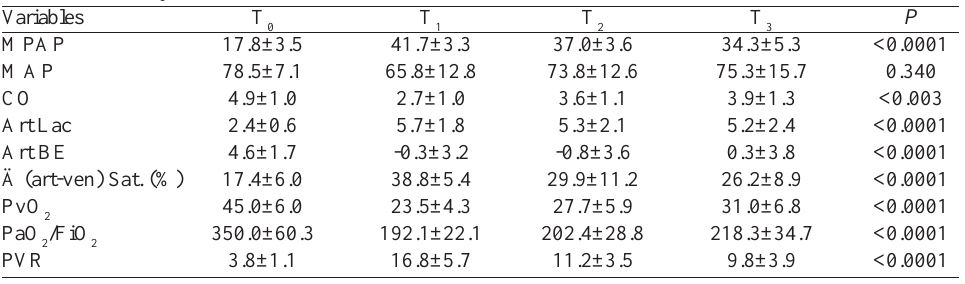
Table 2. Hemodynamic and metabolic variables.